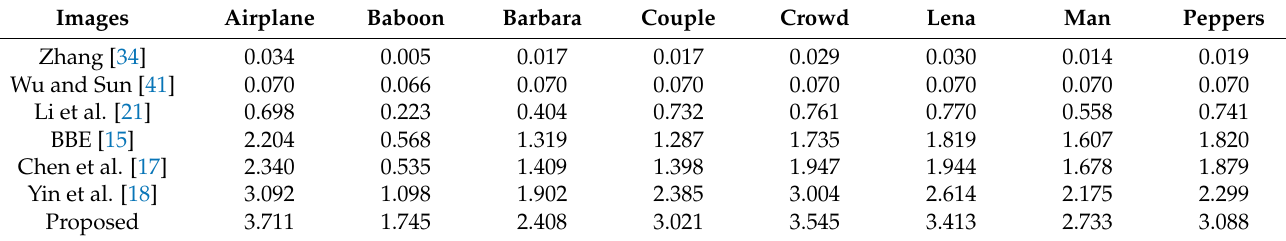
Table 1. Comparison of embedding rates for the eight test images.